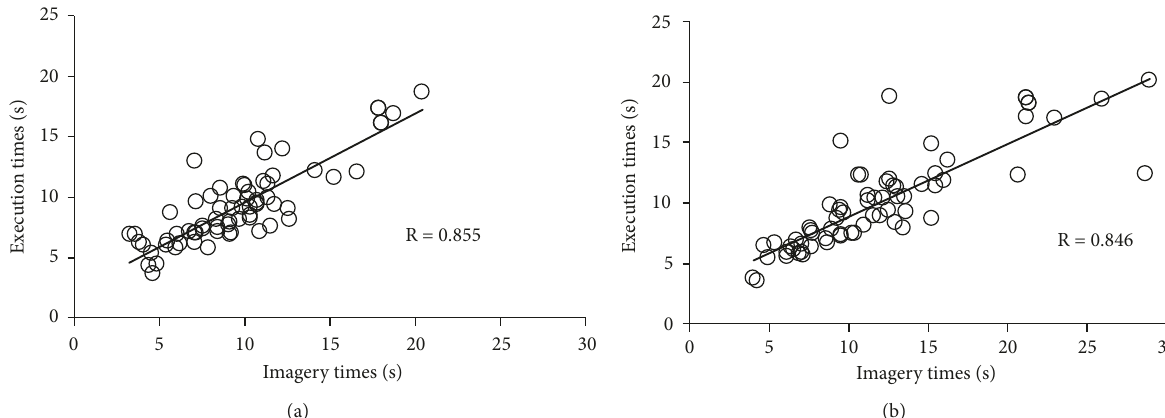
Figure 2: (a) Relationship between imagery and execution times before action observation. (b) Relationship between imagery and execution times after action observation. There was a significant correlation between imagery and execution times both before and after action